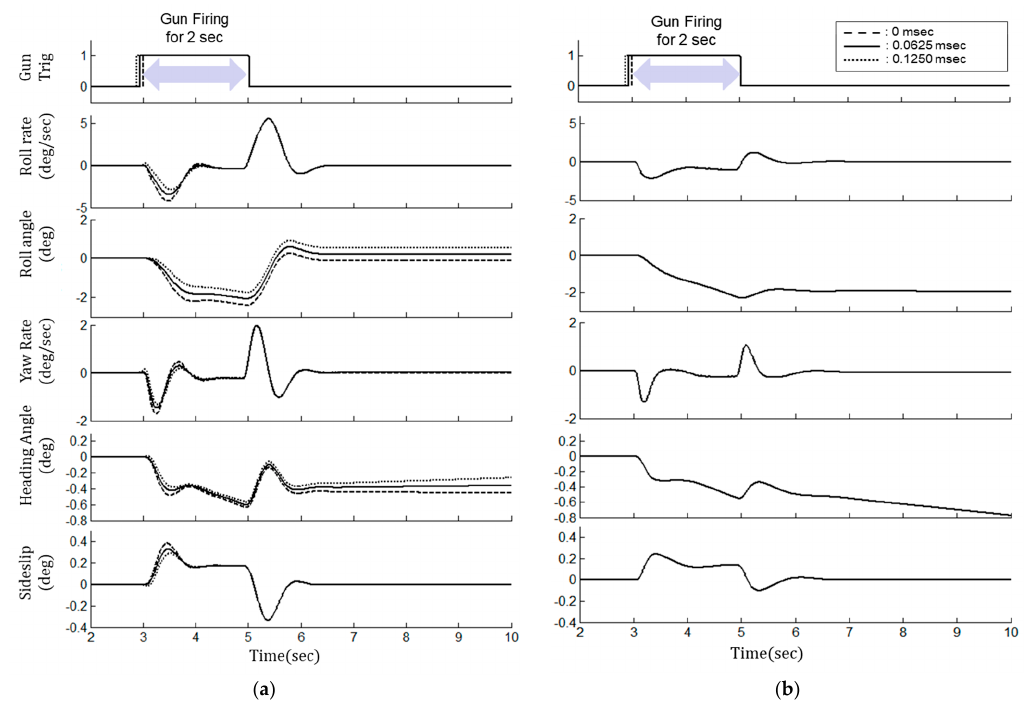
Figure 13. Result of robustness in time delay for each control method at M0.8, 10 kft altitude: ( a ) gun compensation control; ( b ) additional augmentation control.